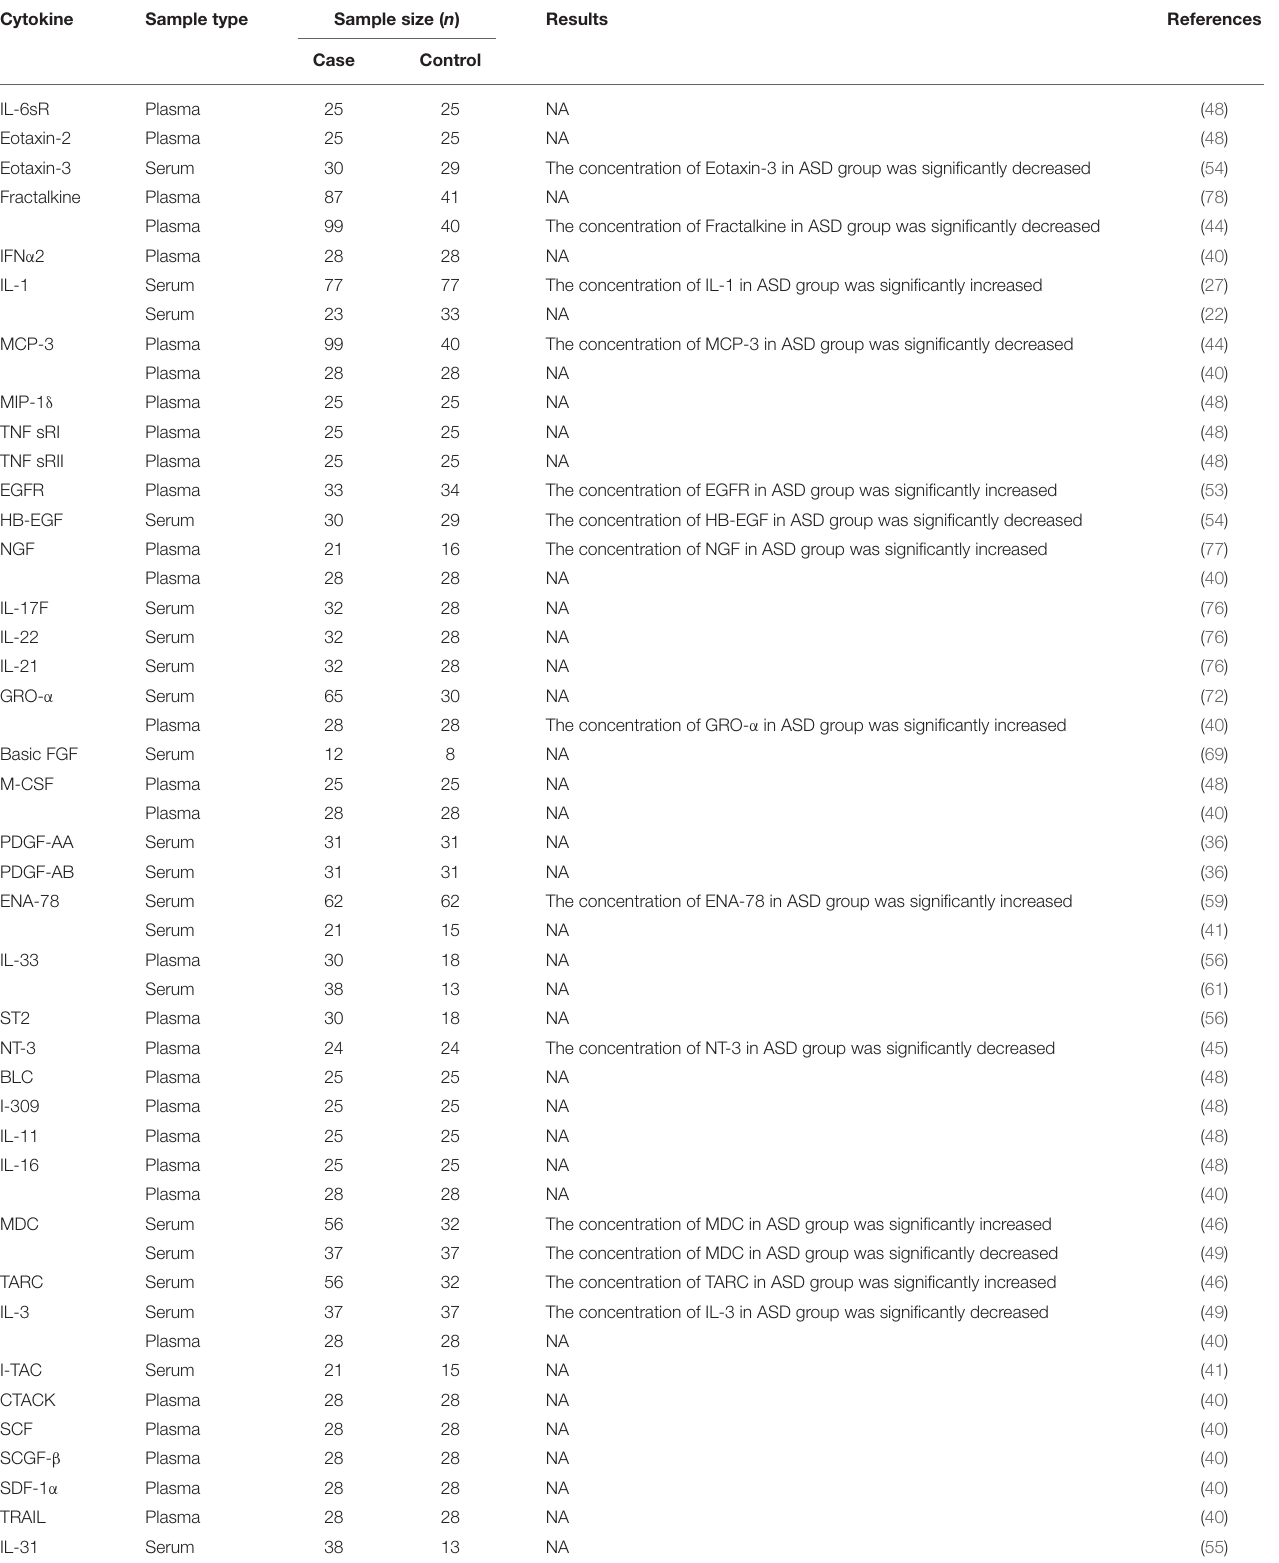
TABLE 1 | Summary of studies on the unanalyzed cytokines.